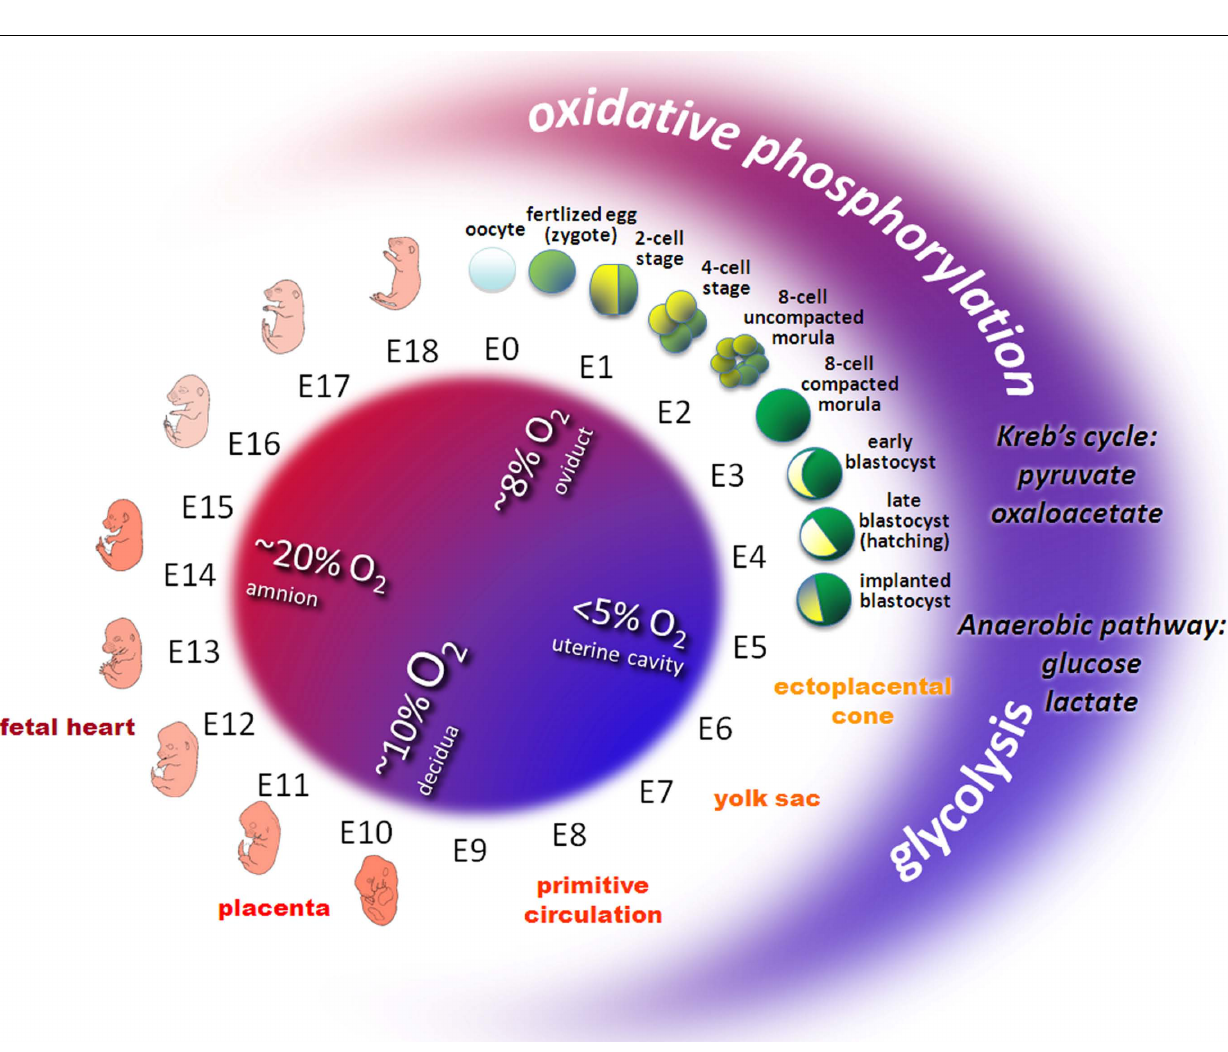
FIGURE 1 | Oxygen and metabolic status during embryo development in mouse. Owing to the variable environmental conditions including oxygen and glucose concentrations in different regions of the female reproductive tract, the developing early embryo has to adapt its energy metabolism. Before the circulation system in the ectoplacental cone, the yolk sac, the placenta and the embryonic heart develop, early embryos transit from relative aerobic (red